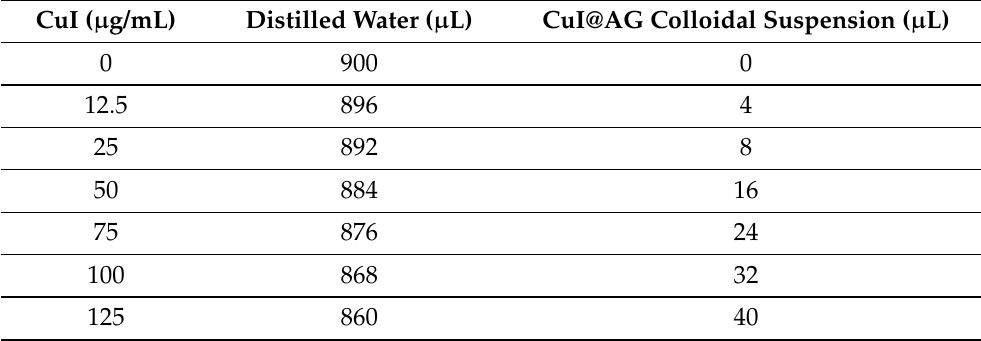
Table 1. Determination of the MIC and MFC of CuI@polymer composites. The exposure of pathogenic fungi was evaluated at different composites